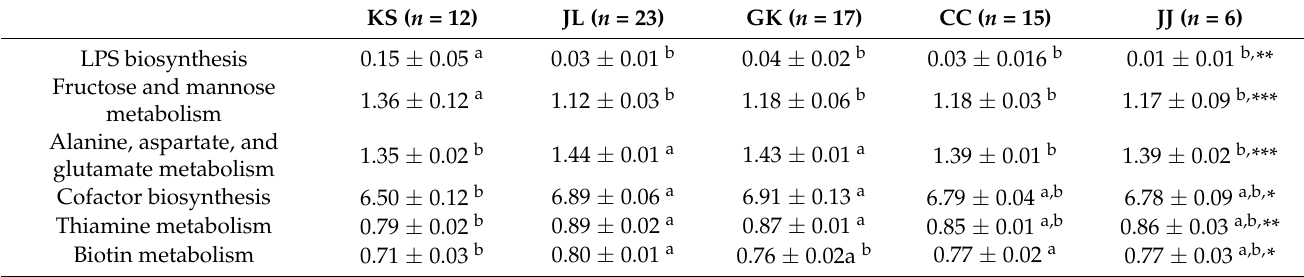
Values indicated means ± standard deviations. Traditionally made Kochujang (TMK) samples from Jeolla ((JL), Jeonbuk + Jeonnam; n = 12), Kyungsang ((KS), Kyungbuk + Kyungnam; n = 12), Geongkang ((GK), Geonggi–Do + Incheon + Kwangwon; n = 17), and Chungcheung provinces ((CC), Chungbuk + Chungnam; n = 15) and Jeju island ((JJ); n = 6) of Korea. * Significantly different among the TMK from different provinces at p < 0.05, ** at p < 0.01, *** at p < 0.001. a,b Different letters on the bars indicate significant differences between the groups by Tukey test ( p <